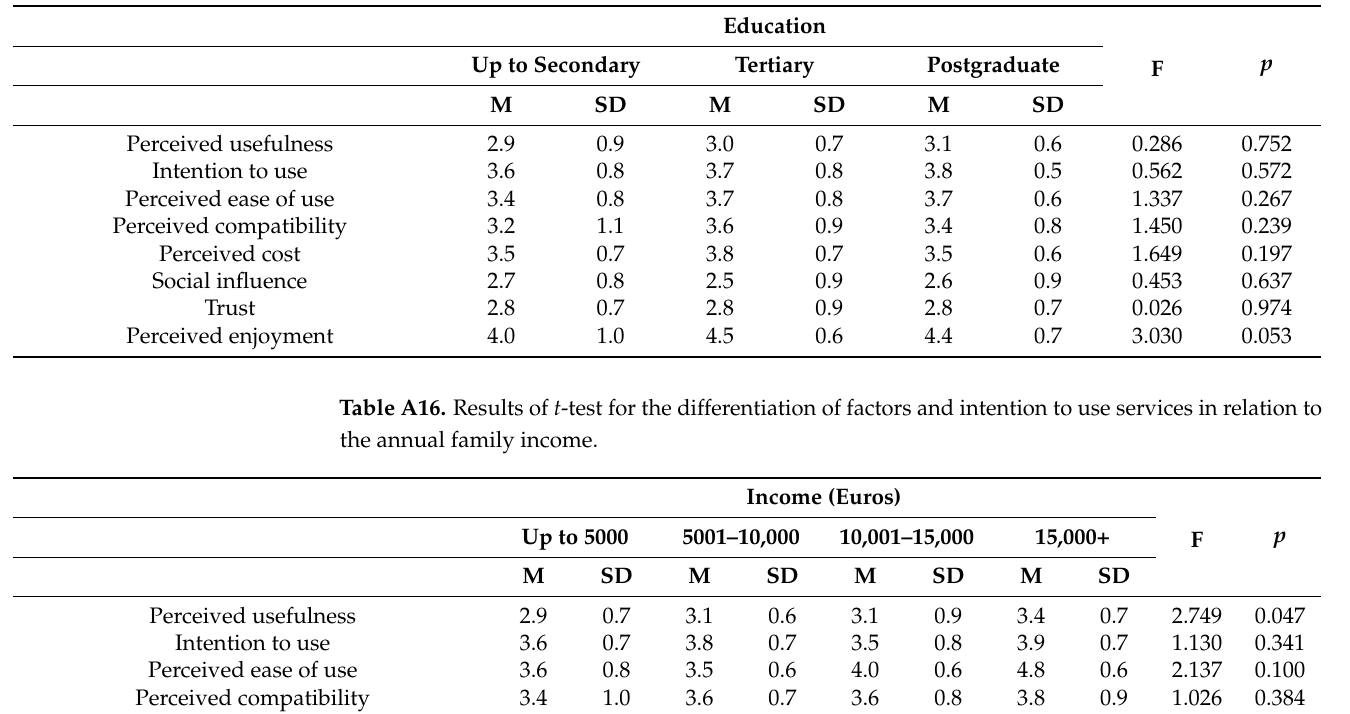
Table A15. Results of t -test for the differentiation of factors and intention to use services in terms of